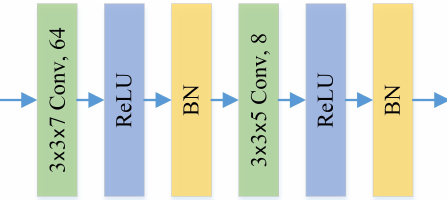
Figure 4. The SSSFE